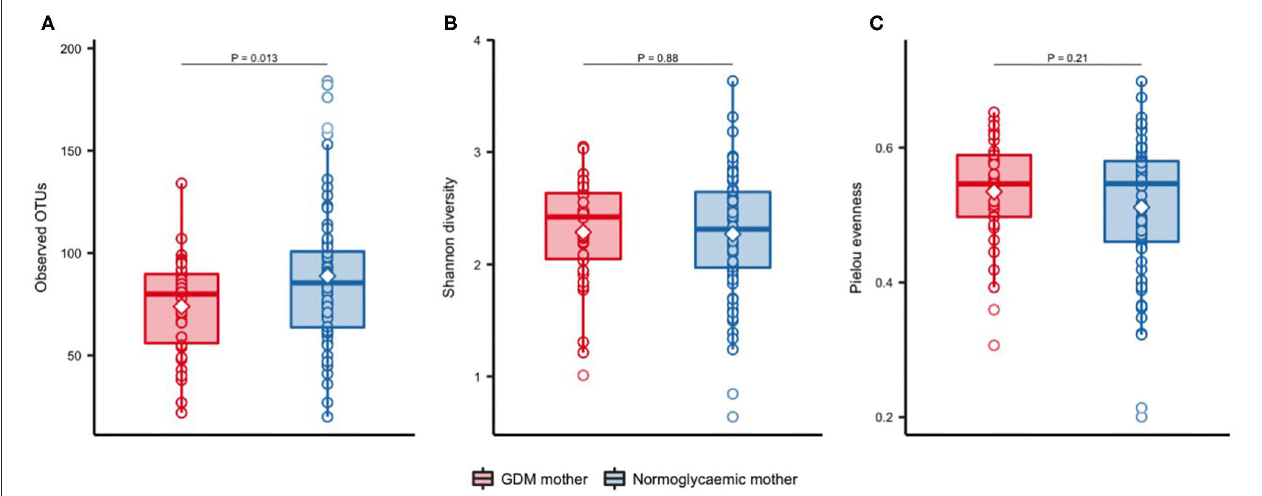
FIGURE 1 | Alpha-diversity of gut microbiota in newborns of mothers with GDM and normoglycaemic mothers. Observed OTUs (A) , Shannon’s diversity (B) , and Pielou’s evenness (C) , in newborns of mothers with GDM ( n = 34) and of normoglycaemic mothers ( n = 72). Samples were rarefied to an equal depth of 10,000 reads. Boxes represent interquartile range (IQR), with the inside line representing the median. Circles represent individual samples. Differences between newborn of mothers with GDM and newborns of normoglycaemic mothers were tested using Students t -test.